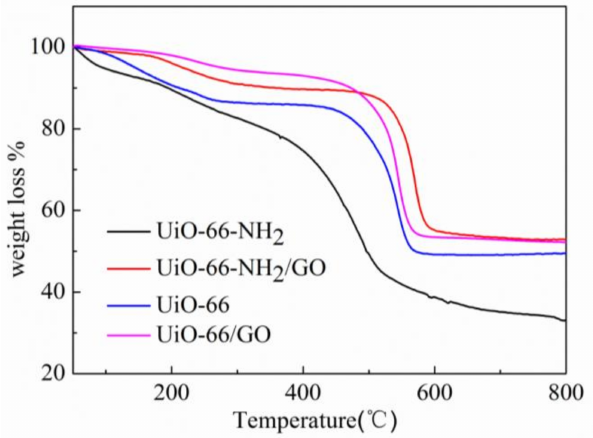
Figure 6. Thermo-gravimetric analysis for the different samples.